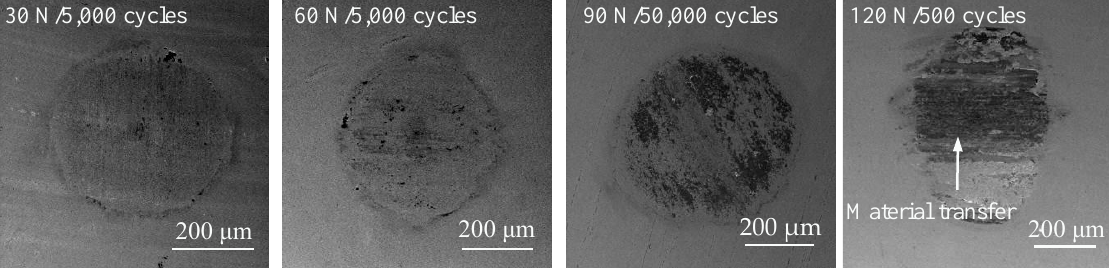
Figure 11. Wear and failure process of CrN coated WC-Co substrate under different normal forces.